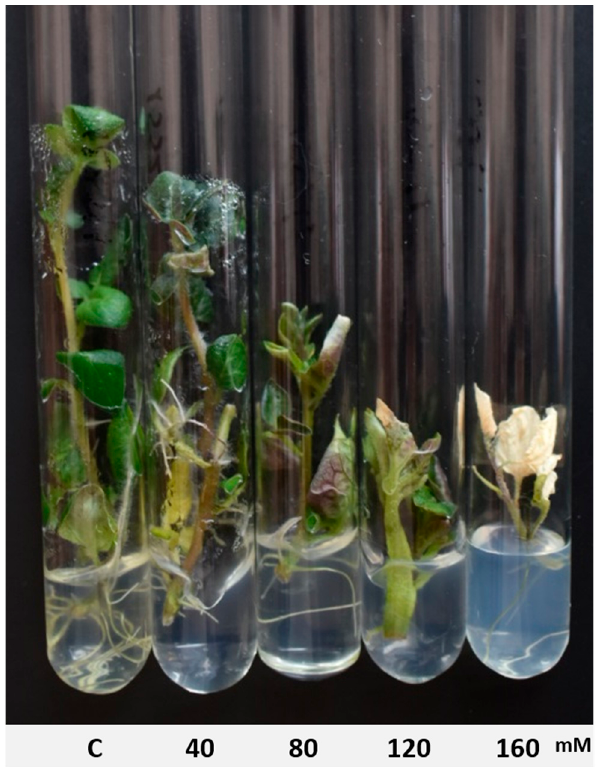
Figure 6. Phenotypic changes of DkDN11.34 during increasing salt concentration of the medium with the control plant (C) and plants in 40, 80, 120, 160 mM concentration of NaCl in culture medium. This genotype tolerated the medium salt-stress (40 mM, 80 mM) but was sensitive to severe salt concentrations of medium (120 mM, 160 mM).